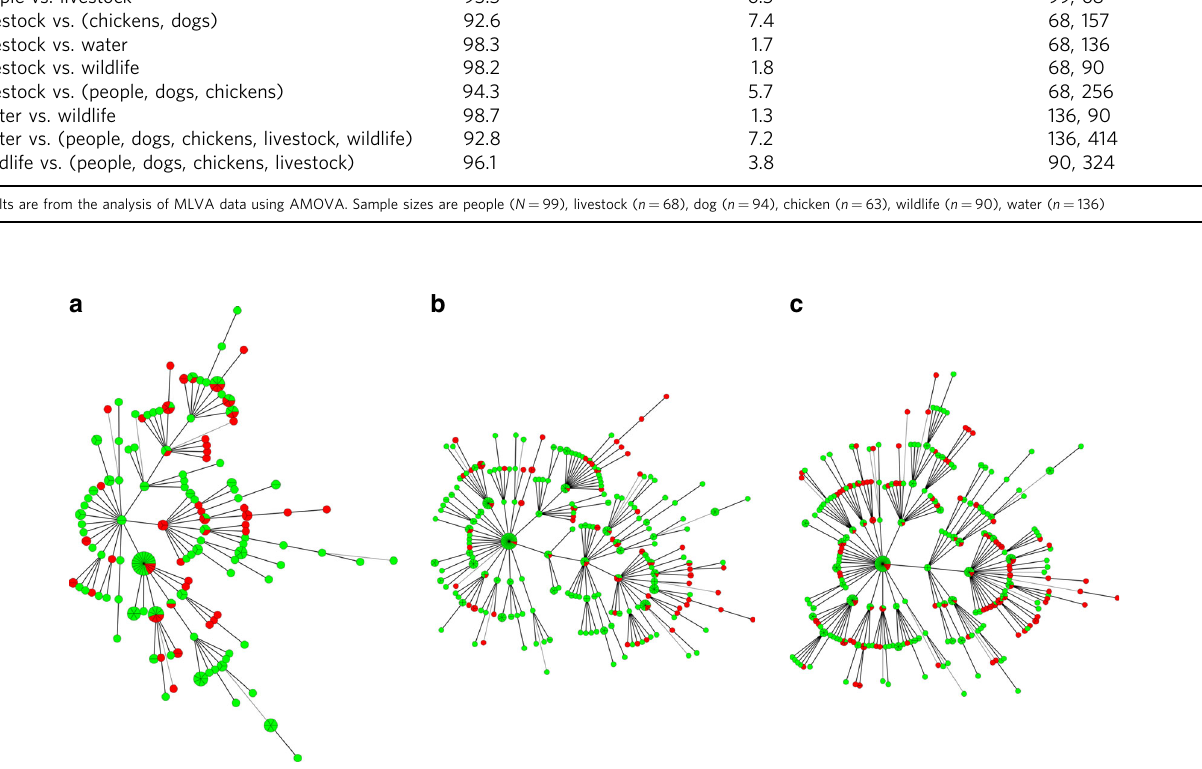
Fig. 4 Minimum spanning tree for E. coli MLVA haplotypes. Each circle or pie-slice represents a single E. coli isolate from people or animal. Most of the isolates differed by a single locus (solid lines) and no host-speci fi c clustering was apparent. Sample sizes are people ( n = 99), livestock ( n = 68), dog ( n = 94), chicken ( n = 63), wildlife ( n = 90), water ( n = 136).